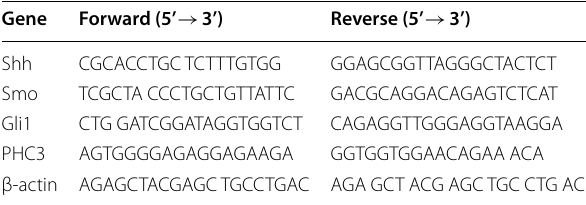
Table 1 List of primers used for QPCR Gene Forward (5’